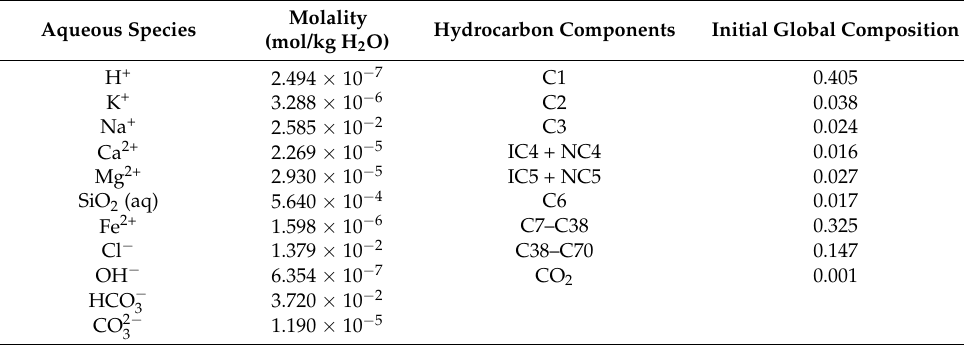
Table 3. Initial conditions of aqueous species and hydrocarbon components.